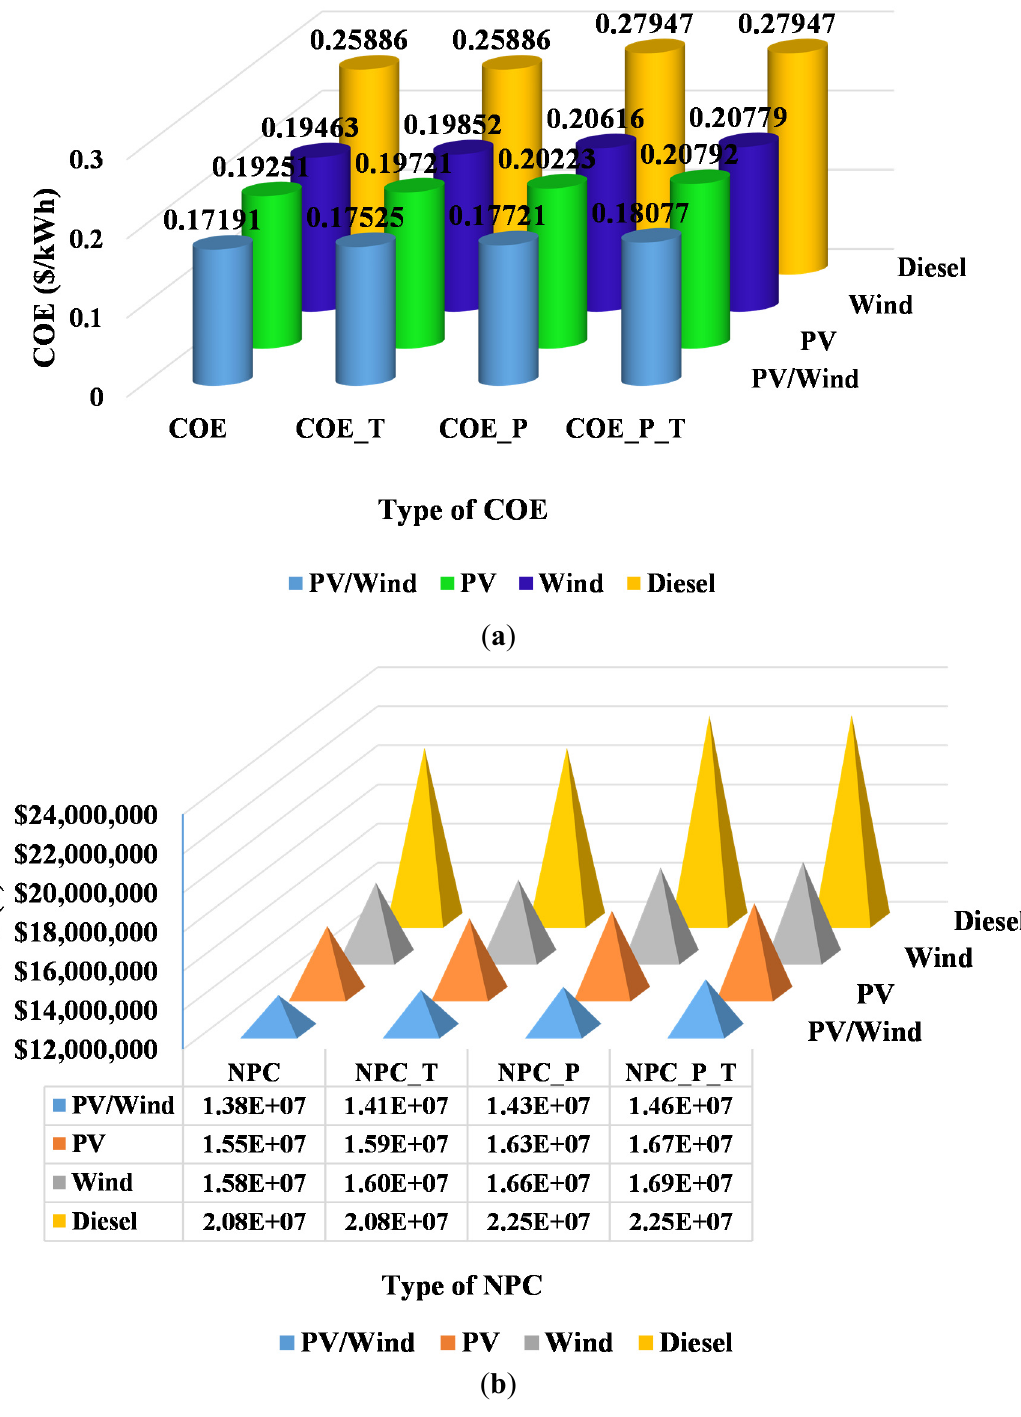
Figure 1. ( a ) The different cost of energy (COE) of photovoltaics (PV)/wind/diesel/battery, PV/diesel/battery, wind/diesel/battery and diesel/battery systems in Alexandria, Egypt. ( b ) The different net present cost (NPC) of PV/wind/diesel/battery, PV/diesel/battery, wind/diesel/battery and diesel/battery systems in Alexandria,